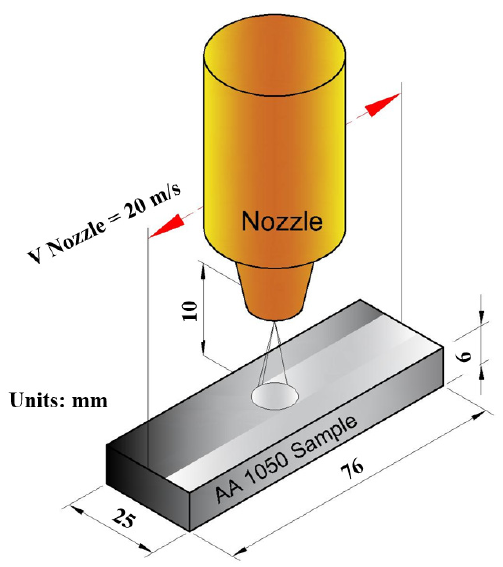
Figure 1. Schematic illustration of the shot-peening of AA1050 alloy samples.